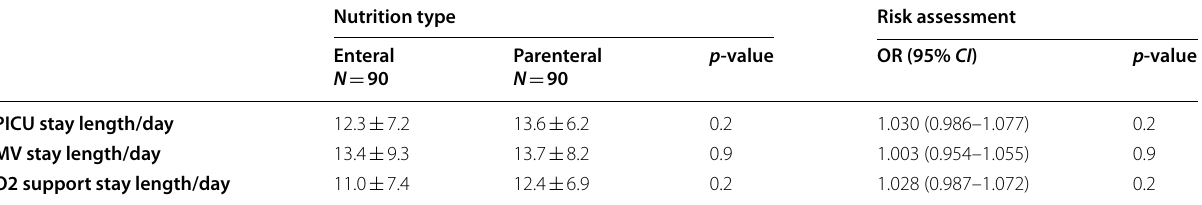
Length-of-stay data are represented as mean